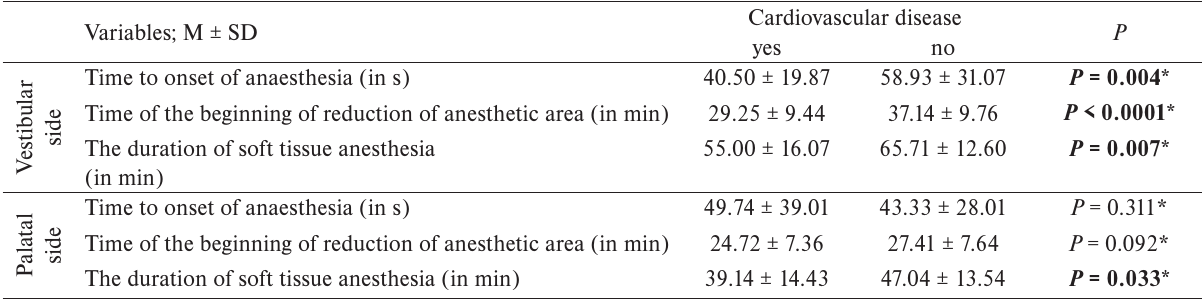
Table 3. Values of local anesthesia parameters in the study